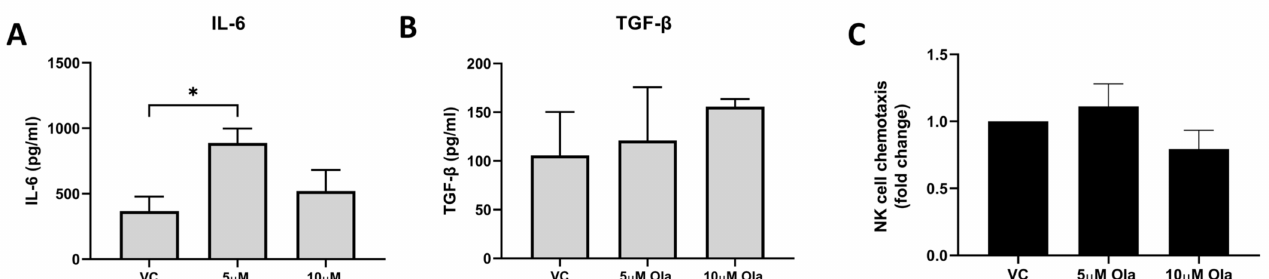
Figure 6. Olaparib treatment significantly altered the secretome of T98G cells in vitro but did not alter their chemoattraction of NK cells. Bar charts showing the levels of soluble ( A ) IL-6 ( n = 7) and ( B ) TGF- β ( n = 3) in the secretome of T98G cells treated with vehicle control (VC) or 5 µ M or 10 µ M of Olaparib for 24 h. ( C ) Bar chart showing NK cell chemotaxis towards supernatants of T98G cells previously treated with vehicle control (VC), 5 µ M or 10 µ M of Olaparib for 24 h ( n = 5). * p < 0.05, by one-way ANOVA with post hoc Dunn’s